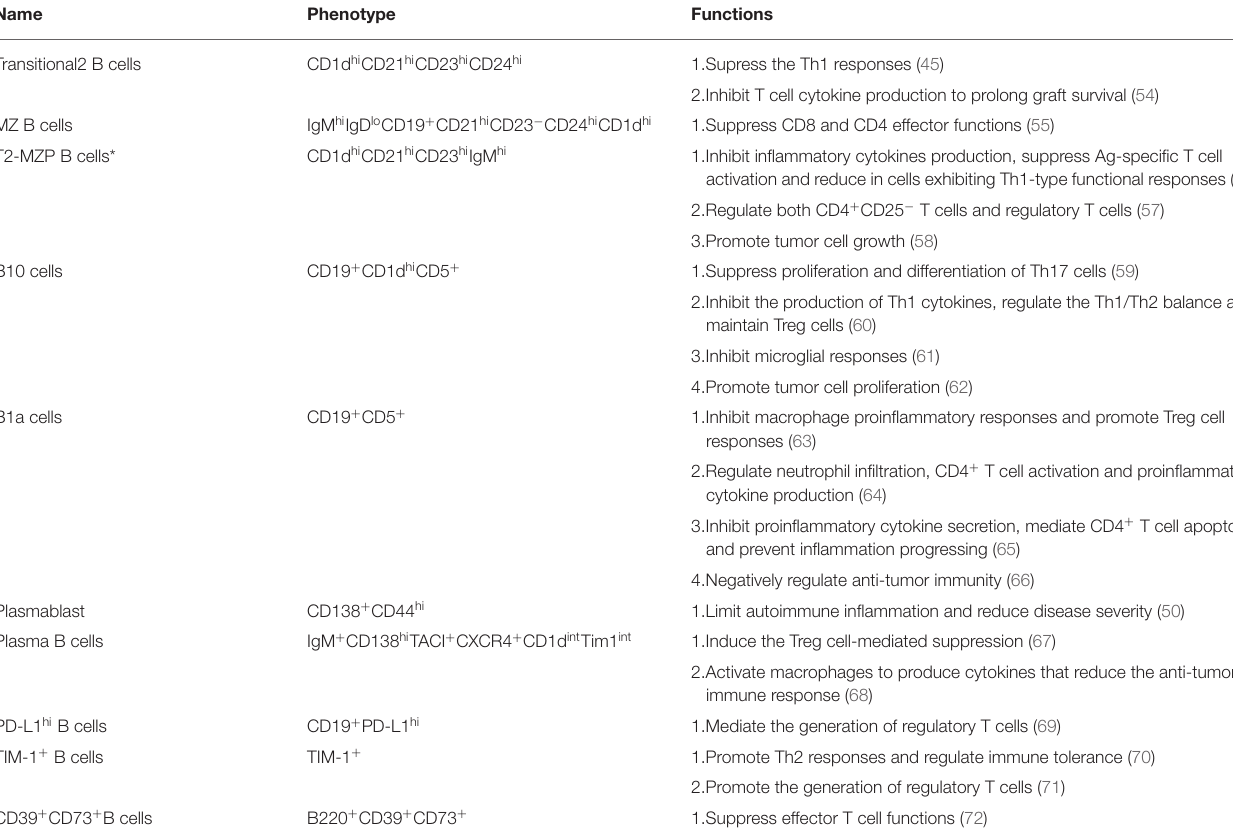
TABLE 1 | The phenotype and function of mouse regulatory B cell